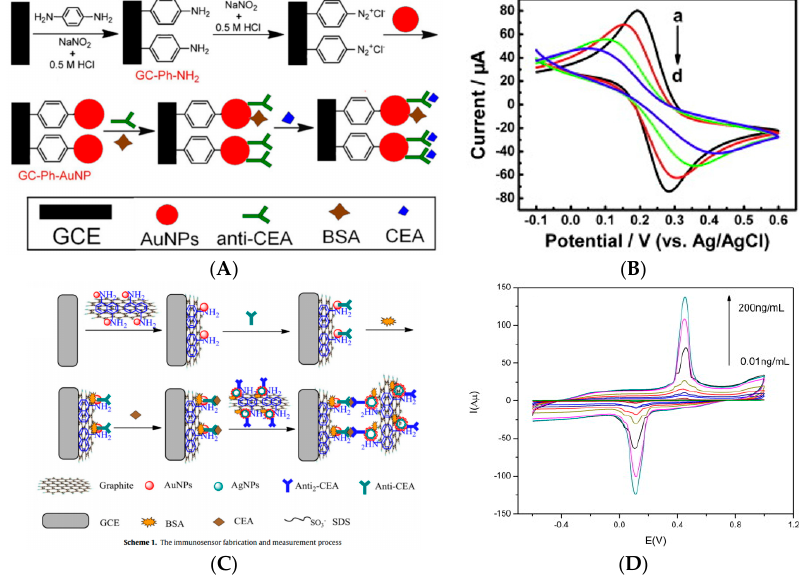
Figure 24. ( A ) GC/Ph/AuNP competitive immunosensor for CEA detection; ( B ) CVs of the modified electrode in 10 mM [Fe(CN) 6 ] 4 − /3 − + 0.1 M KCl, for (a) a bare electrode; (b) NH 2 -Ph-NH 2 -modified